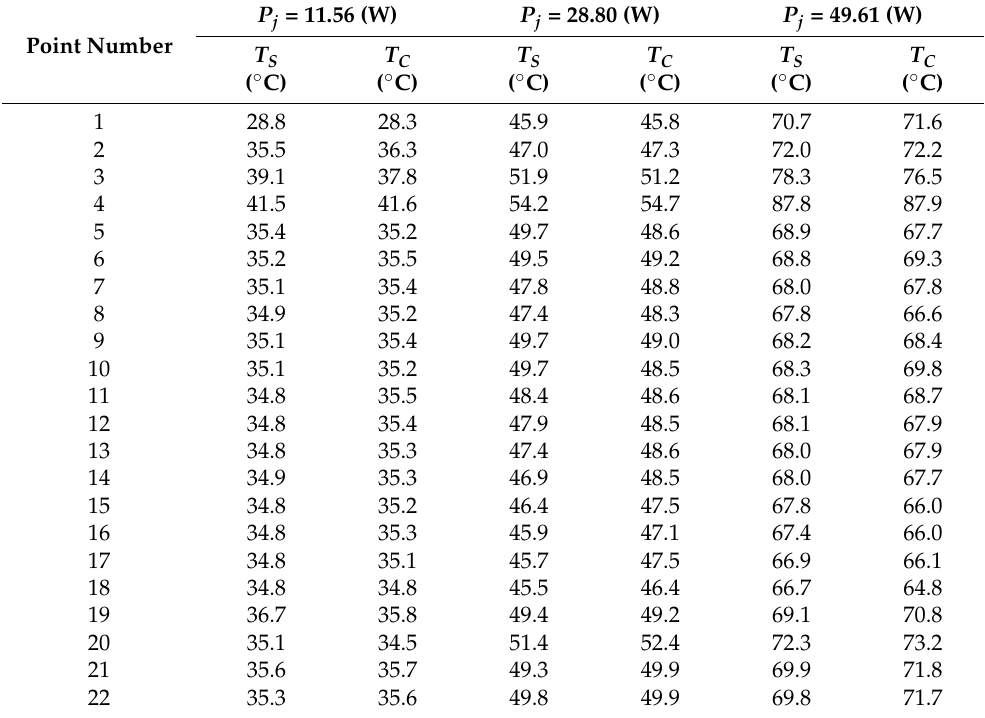
Table 4. The temperature values obtained from T S simulations and T C measurements for each of the points presented in Figure 2 for P j = 11.56 W, P j = 28.80 W and P j = 49.61 W.